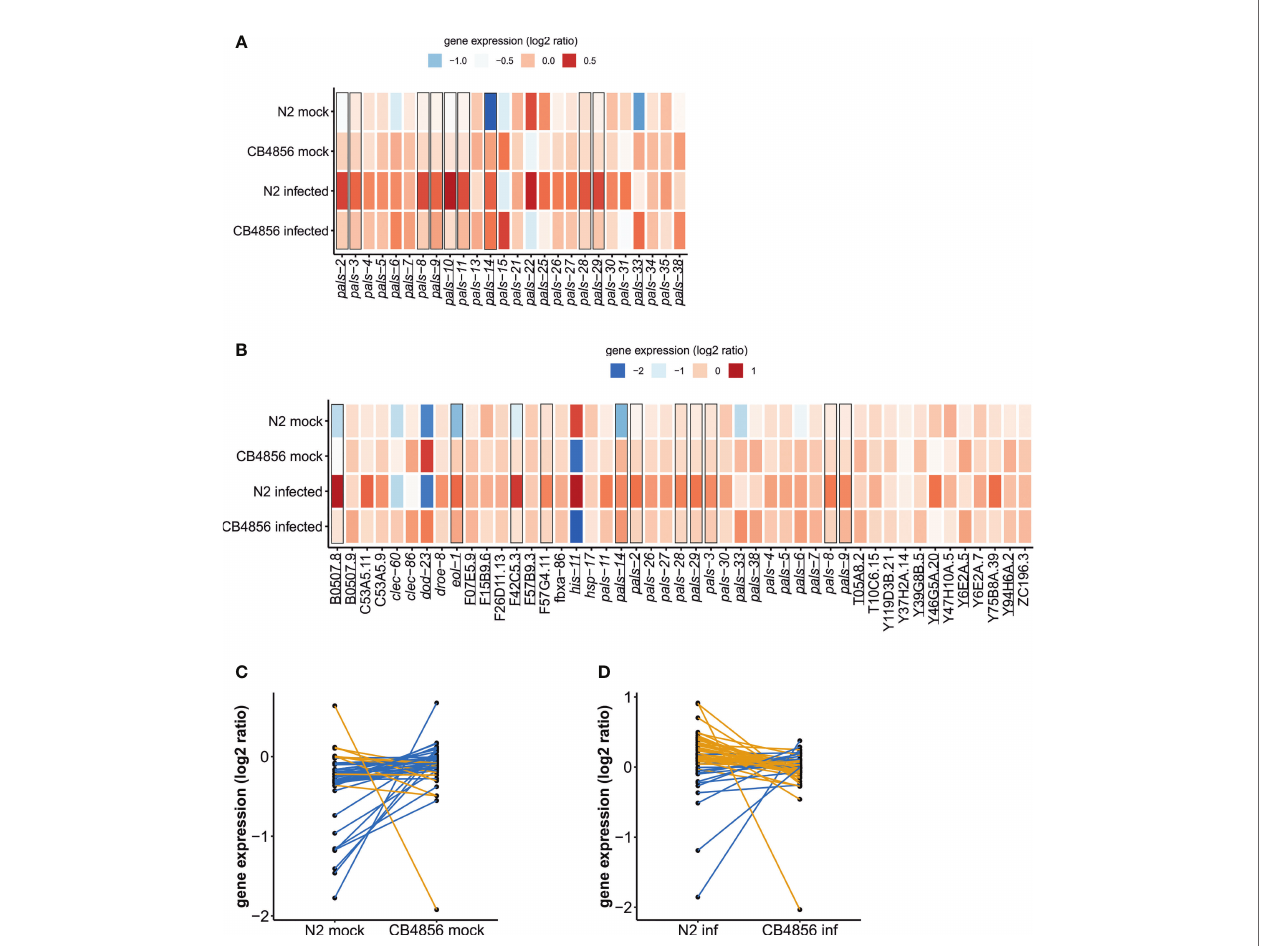
FIGURE 4 | Gene expression of IPR and pals -genes in C. elegans N2 and CB4856 under control and OrV-infected conditions – (A) Heat-map showing the log 2 intensities of pals -genes in N2 mock, N2 infected, CB4856 mock and CB4856 infected conditions (B) Heatmap showing the expression of IPR genes in log 2 intensities in N2 mock, N2 infected, CB4856 mock and CB4856 infected conditions. Underlined genes showed signi fi cant (basal) expression differences based on genotype (FDR < 0.05), whereas squares indicated the genes where treatment- or the combination of treatment and genotype had a signi fi cant effect (FDR < 0.1) ( Supplementary Table S7 ). Log 2 ratios are based on the average expression of the gene of interest in the overall dataset. Therefore, the log 2 ratios per experimental group indicate the deviation from the average value. Please note, a subset of the pals -genes, namely the pals -genes that are also IPR genes [de fi ned in (Reddy et al., 2019)] are depicted twice. This allows for direct comparison to other pals -genes that do not become differentially expressed upon infection (like pals-22 and pals-25 ) and to non- pals IPR genes. (C) Per IPR gene comparison of the log 2 ratios in N2 and CB4856 samples under mock conditions. Blue lines show genes that on average showed higher expression in CB4856 (38 genes), orange lines connect genes that on average showed higher expression in N2 (9 genes). (D) Per IPR gene comparison of the log 2 ratios in N2 and CB4856 samples under infected conditions. Blue lines show genes that on average showed higher expression in CB4856 (14 genes), orange lines connect genes that on average showed higher expression in N2 (33